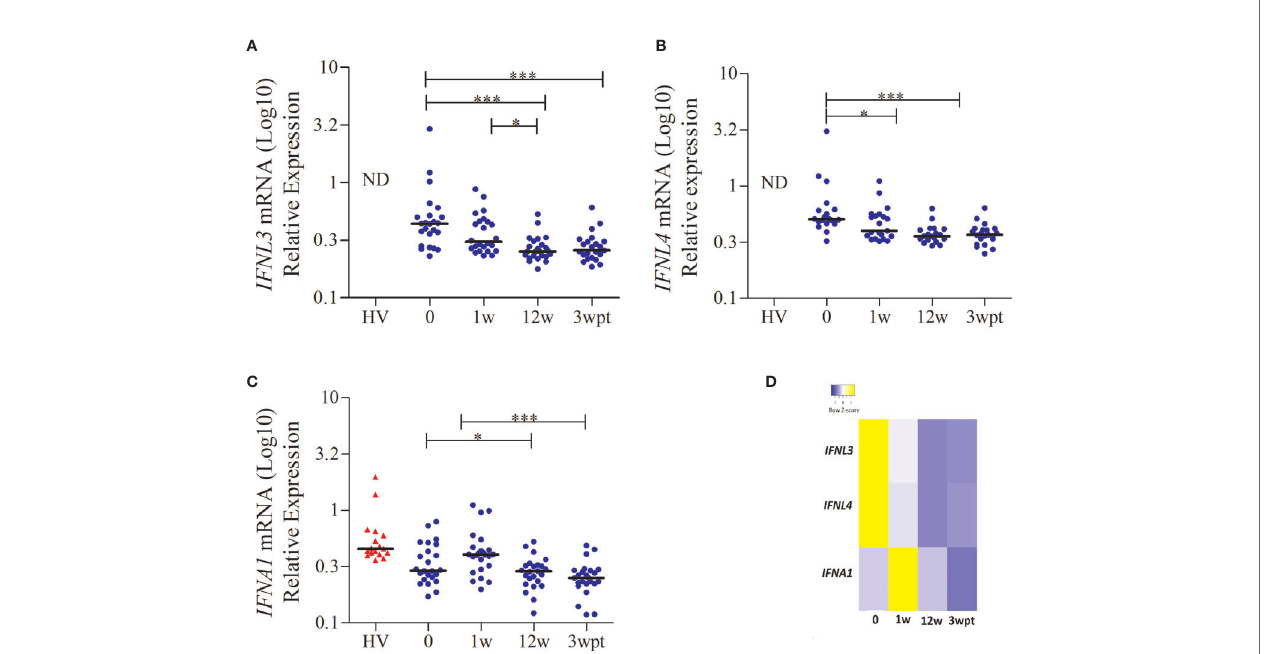
FIGURE 3 | IFNL3, IFNL4, and IFNA1 gene expression in patients with CHC during the treatment with Peg-IFN a and RBV. (A) IFNL3 ; (B) IFNL4 ; (C) IFNA1 and (D) Heat map showing the antagonistic effect between the expression of IFNL3/4 and IFNA1 . Statistical analysis was performed by the Kruskal-Wallis test and